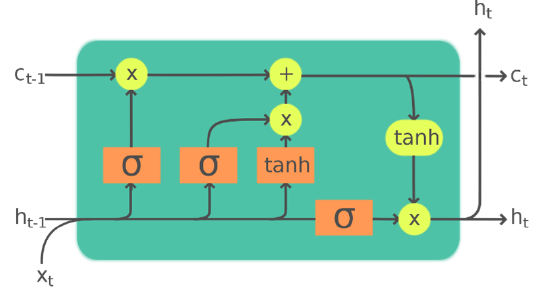
Figure 3. Depiction of an LSTM